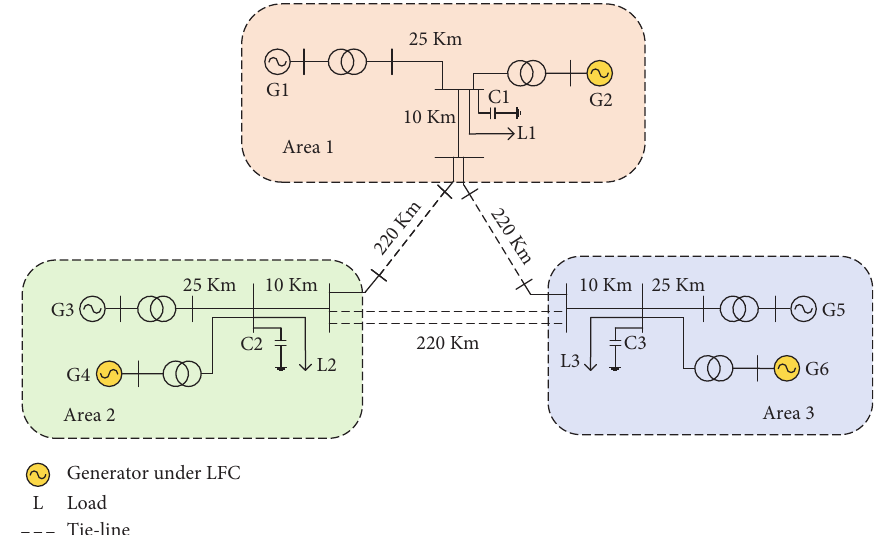
Figure 1: Three-area power